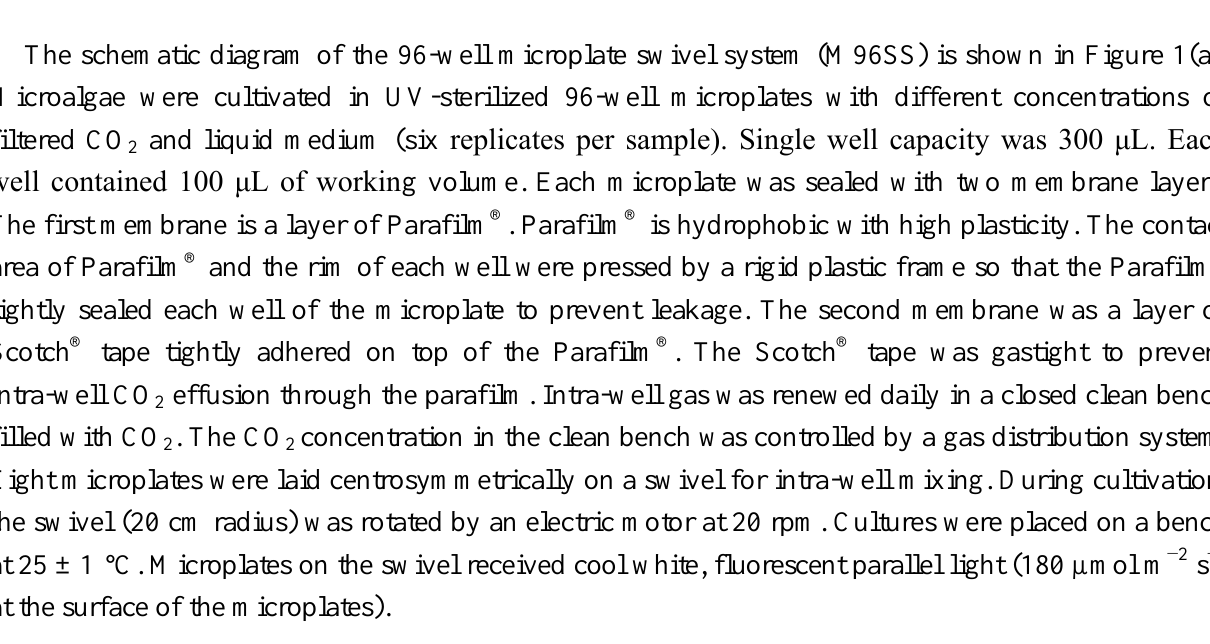
Table 1. Regression functions of OD